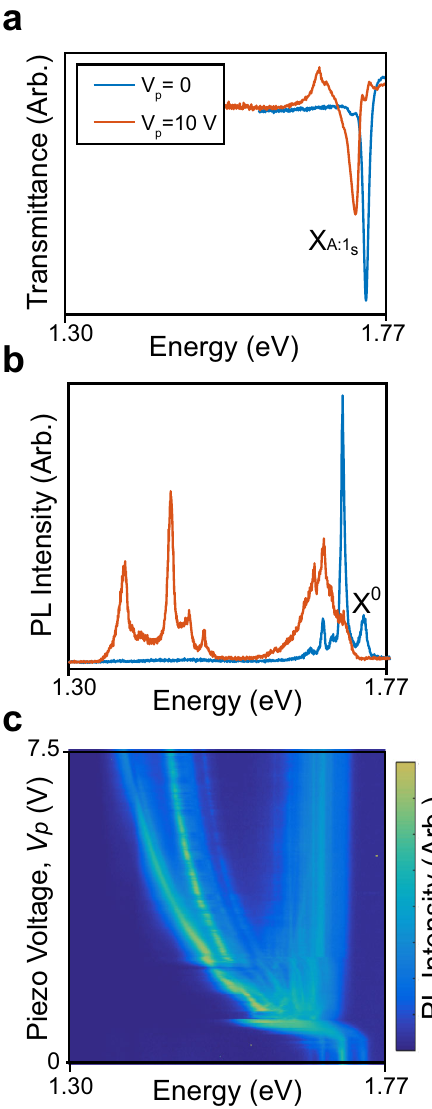
Fig. 2 Strain-induced excitonic response in transmittance and PL with large tunability at T = 5 K. a For device D3 , we present the transmittance dip associated with X A:1s with V p = 0 (before contacting the heterostructure with the fi ber) and with V p = 10 V (the maximum voltage we can apply to the piezo-positioner). The X A:1s feature shifts by 35 meV over this range. b The fi ber-collected PL has a feature X 0 that matches in energy with X A:1s at V p = 0. At V p = 10 V, peaks as low as 1.38 eV appear. c PL spectra as a function of piezo-positioner voltage shows two branches of features. The branch that is lower in energy shifts by 390 meV from the unstrained X 0